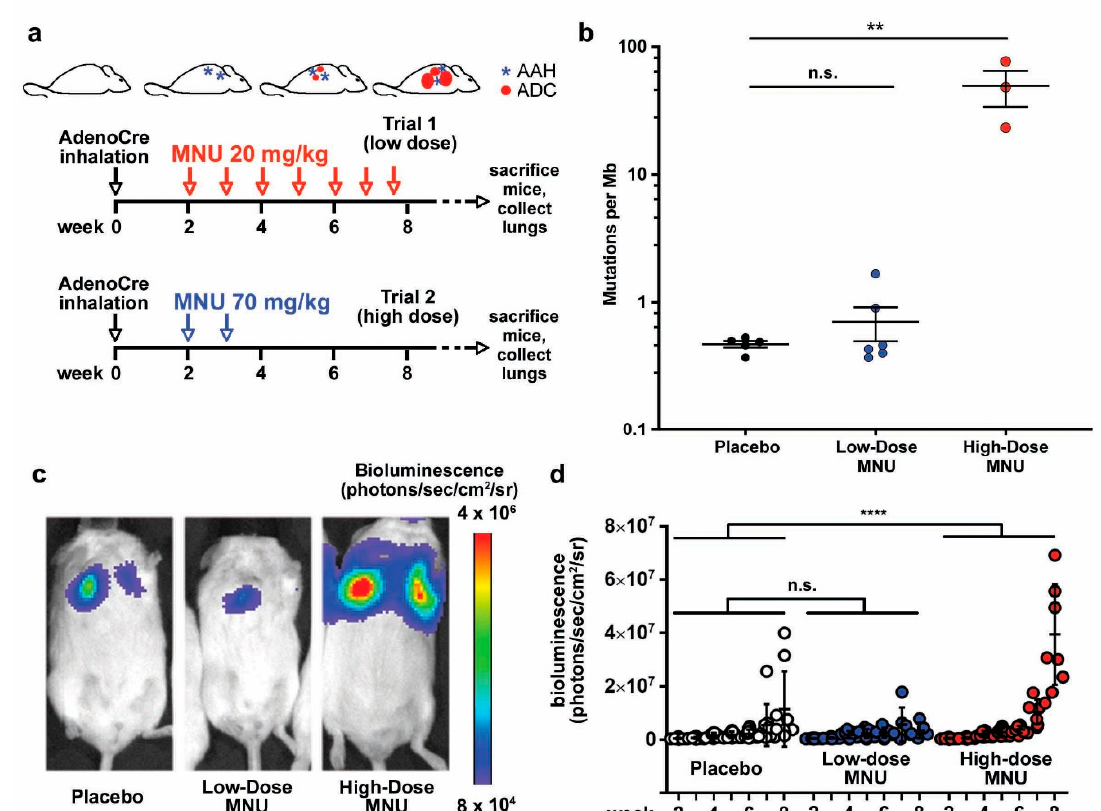
Figure 1. MNU treatment increases the mutation burden and affects tumor growth in a genetically engineered murine model (GEMM) of lung cancer. ( a ) Schematic representation of the treatment regimens. Lung tumors are induced in KP mice by intranasal instillation of AdenoCre. After AdenoCre inhalation, mice develop pre-malignant lesions (atypical adenomatous hyperplasia; AAH) and adenocarcinomas (ADC) with a predictable timing. Mice were treated with either eight low doses (20 mg/kg, trial 1) of MNU or with two high doses (70 mg/kg, trial 2), both on a weekly basis. Each of the two treatment regimens had a corresponding placebo group. At the end of the trials, the mice were euthanized and the tumors collected. ( b ) Mutation burden was measured in tumors from the placebo and the two treatment regimens by WES at the end of the trials, and expressed as mutations per Mb, mean ± standard error of the mean (SEM). The differences in mutation numbers were evaluated by Student’s t -test. ( c , d ) Tumor burden was estimated in the placebo mice and in the two MNU regimens by weekly BLI. ( c ) Representative images of BLI in the placebo and the two treatment regimens at 8 weeks after tumor induction. ( d ) Quantification of the BLI in the placebo and the two MNU regimens (low-dose and high-dose). The differences in tumor burden (log scale) in the different treatment groups were assessed using a generalized estimating equation (GEE) model [18] to accurately account for the same mouse being measured multiple times. ** p < 0.01; **** p <